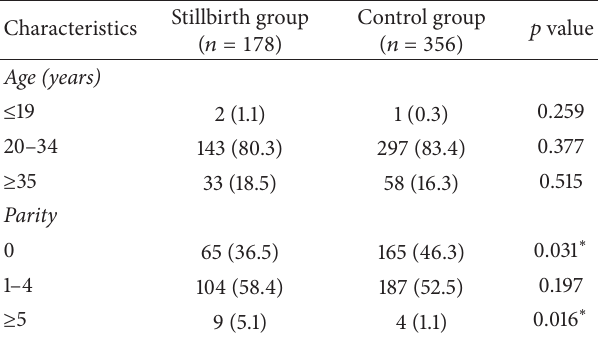
Table 1: Maternal age and parity a .